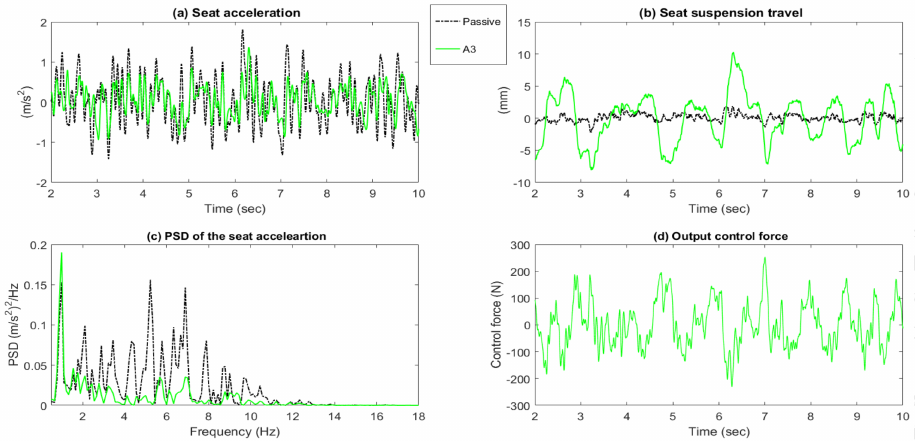
Figure 16. Time responses and PSD of the passive system and active seat suspension with controller